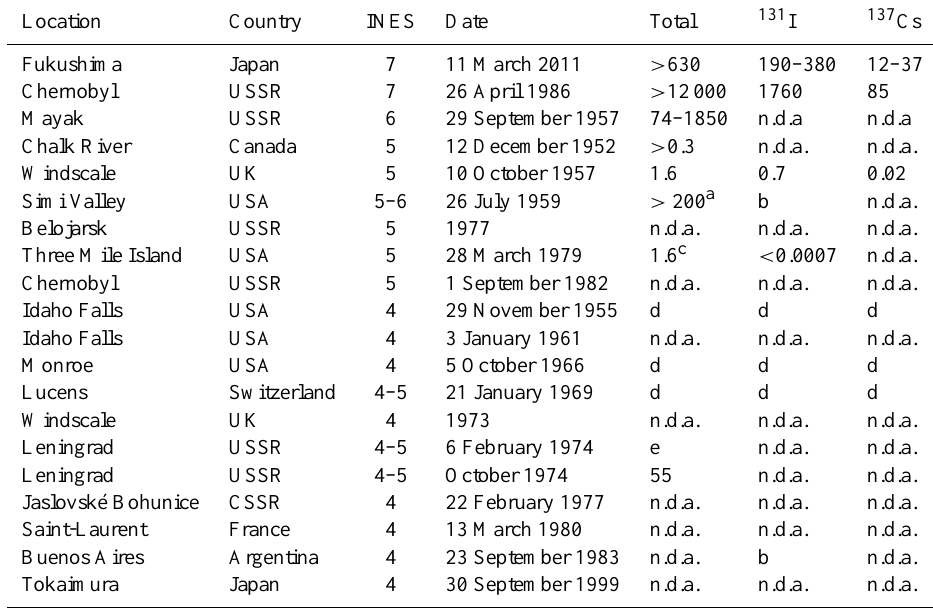
Table 1. Radioactivity released to the atmosphere by INES 4–7 nuclear accidents (in PBq).